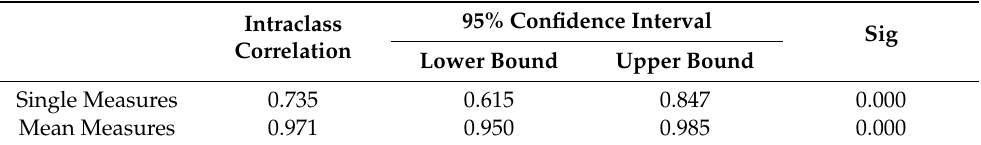
Table 7. Intraclass Correlation Coefficient.